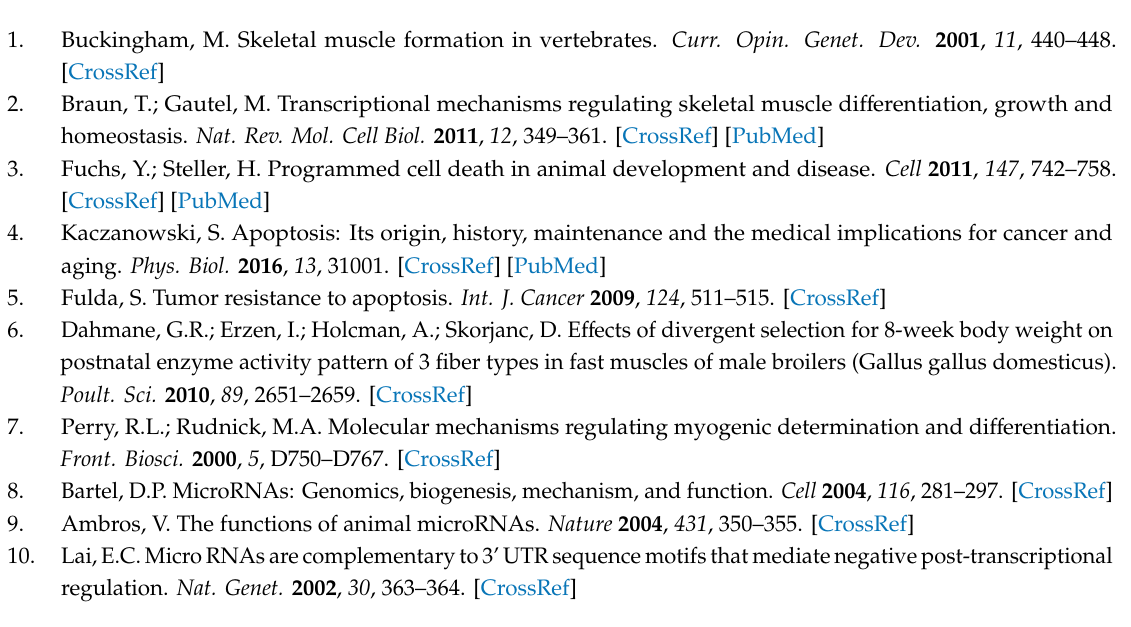
Figure S1: The transfection e ffi ciency of plasmids and RNA oligonucleotides. Figure S2: The relative mRNA expression levels of cell di ff erentiation-related genes after transfection of miR-146-3p mimic or inhibitor in QM-7 cells. Figure S3: The e ff ects of miR-146b-3p, AKT1 and MDFIC on the protein levels of lamin B. Figure S4: The target relationship between miR-146b-3p and AKT1 or MDFIC . Figure S5: The e ff ects of AKT1 or MDFIC on proliferation in QM-7 cells. Figure S6: The e ff ects of AKT1 or MDFIC on di ff erentiation and apoptosis in QM-7